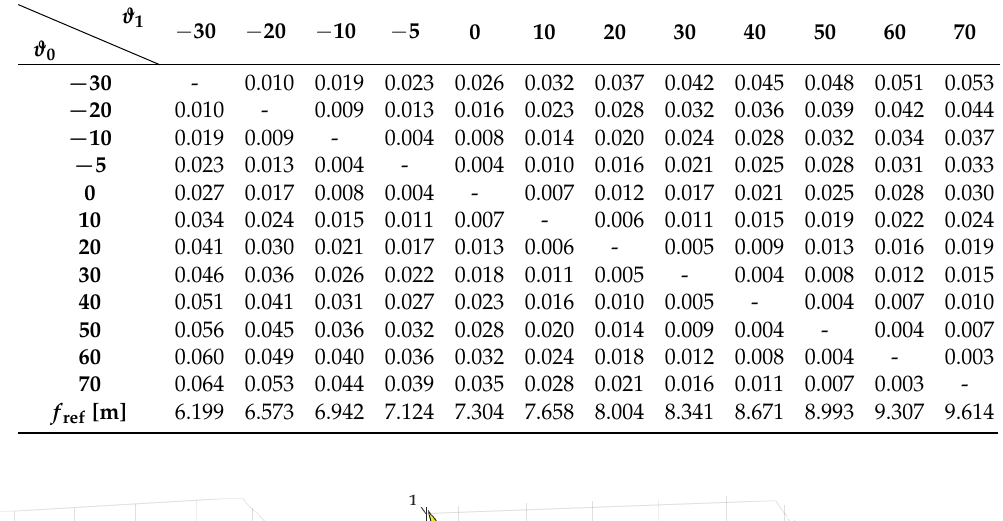
Table 6. Maximum absolute sag deviations ∆ fE [m] caused by the incorrect determination of the conductor elasticity modulus by ± 10%.